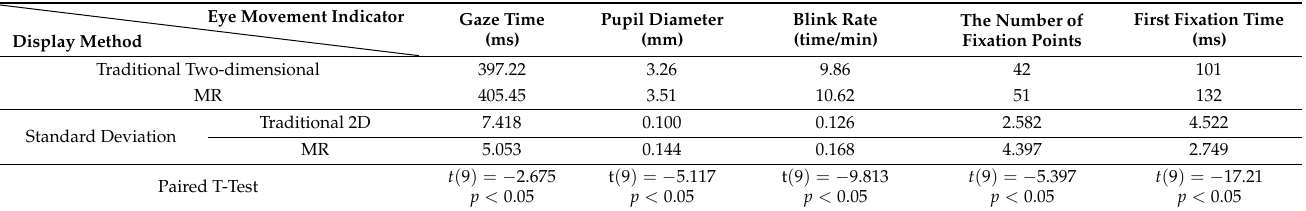
Table 3. Average data and standard deviation data of eye movement characteristics of traditional 2D display interactive system and MR display interactive system.